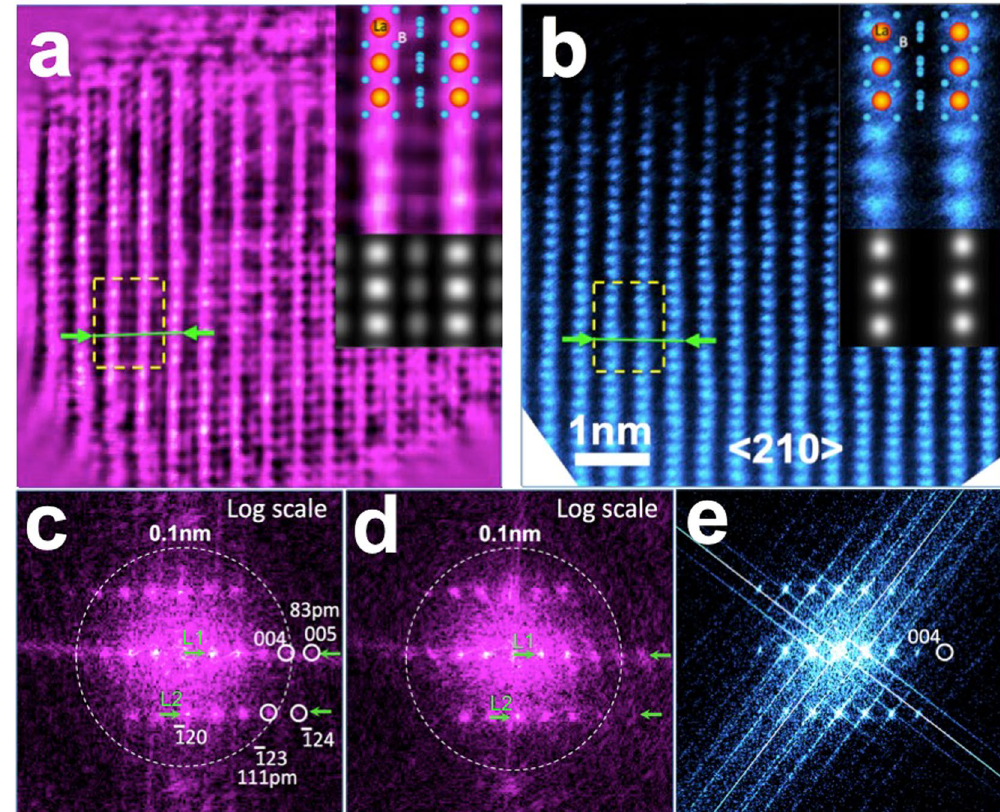
Figure 2. ( a ) Phase of the ptychographic reconstruction corresponding to the green boxed region in Fig. 1b. ( b ) HAADF image from the blue box region in Fig. 1b. ( c ) and ( d ) Power spectra of the reconstructed phase and the complex object wave displayed on a logarithmic intensity scale, respectively. ( e ) Power spectrum of the HAADF image also displayed on a logarithmic intensity scale. Circles indicate (004), (124) and (005) reflections of the LaB 6 lattice corresponding to spacings of 104 pm, 91 pm and 83 pm. The dotted circle indicates a 100 pm spatial resolution limit. Insets to ( a ) and ( b ). Upper: Enlarged phase of the ptychographic reconstruction and HAADF image extracted from the regions indicated by the yellow dashed squares overlaid with a projected atomic model of the LaB 6 structure along a < 210 > direction. Lower: corresponding multislice